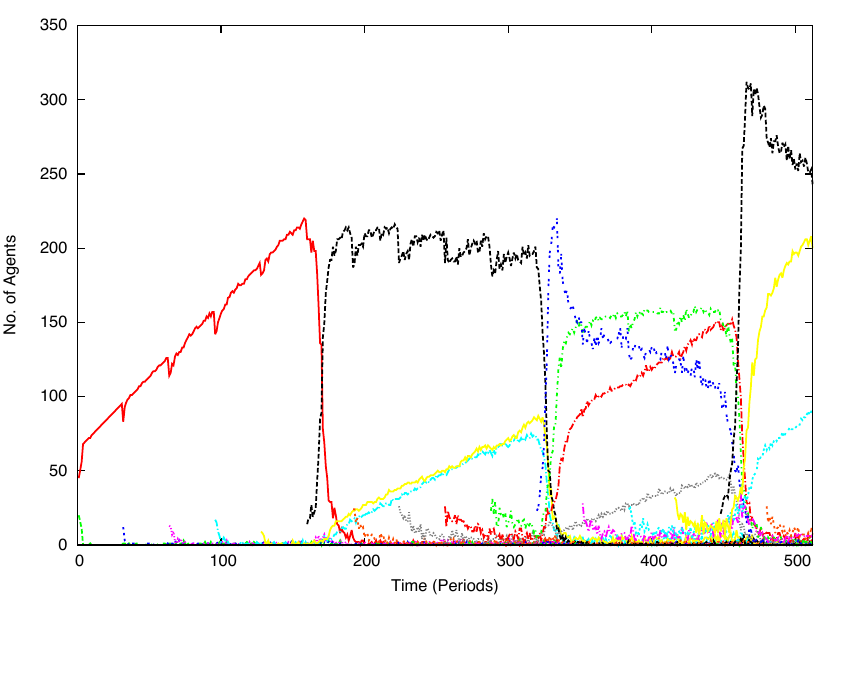
Figure 5. Development of the number of adherents to the different institutions (shown in different colors) for ↵ = 1 . 5 .